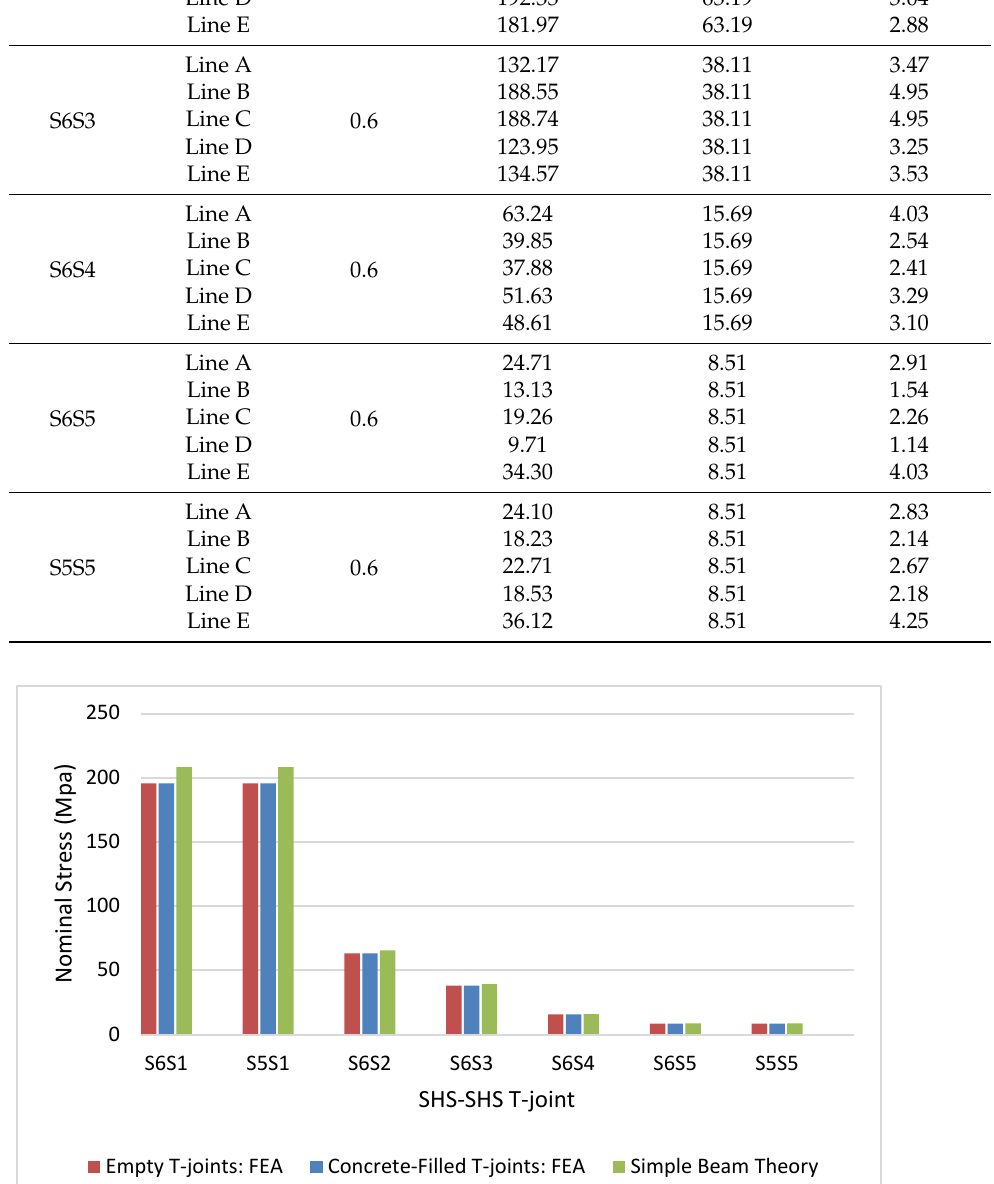
Table 5. Numerical and simple beam theory nominal stresses.